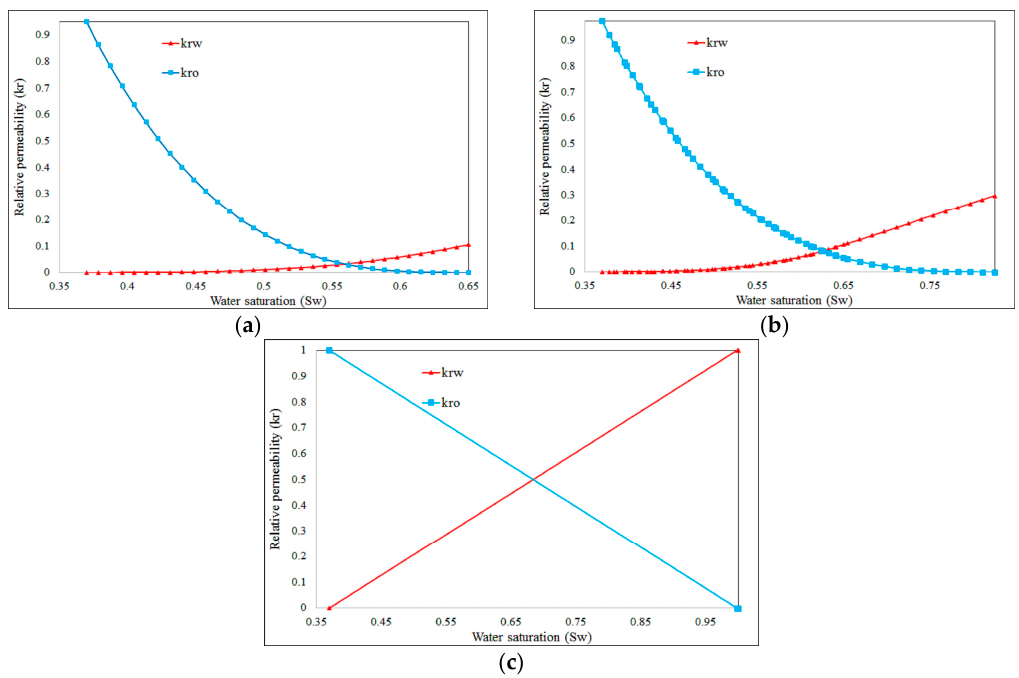
Figure 2. Progression of relative permeability curves following the increase of surfactant: ( a ) initial condition; ( b ) intermediate curves formed by interpolation scheme; ( c ) straighten curves.